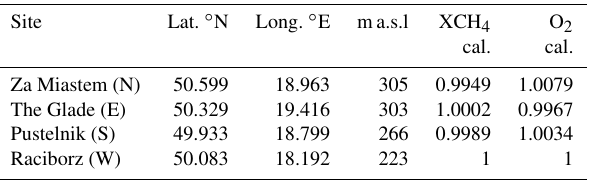
Table 1. Calibration factors towards the western station Raciborz for each instrument and species, along with the nominal geolocation in the network. Site Lat. ◦ N Long. ◦ E